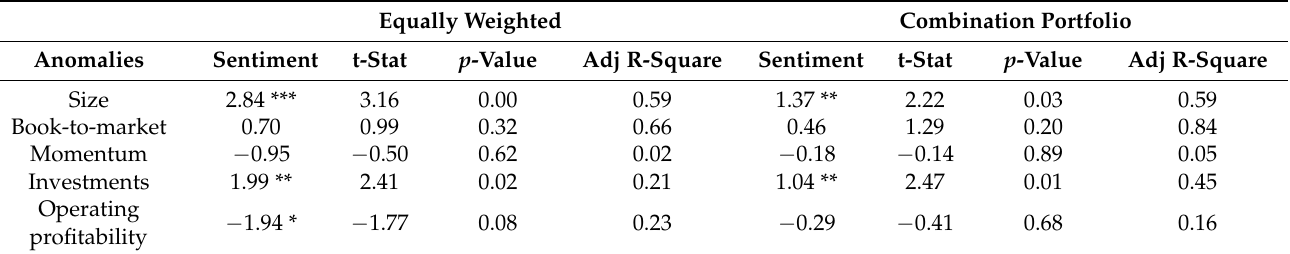
Table 10. Using combination portfolios for US data.